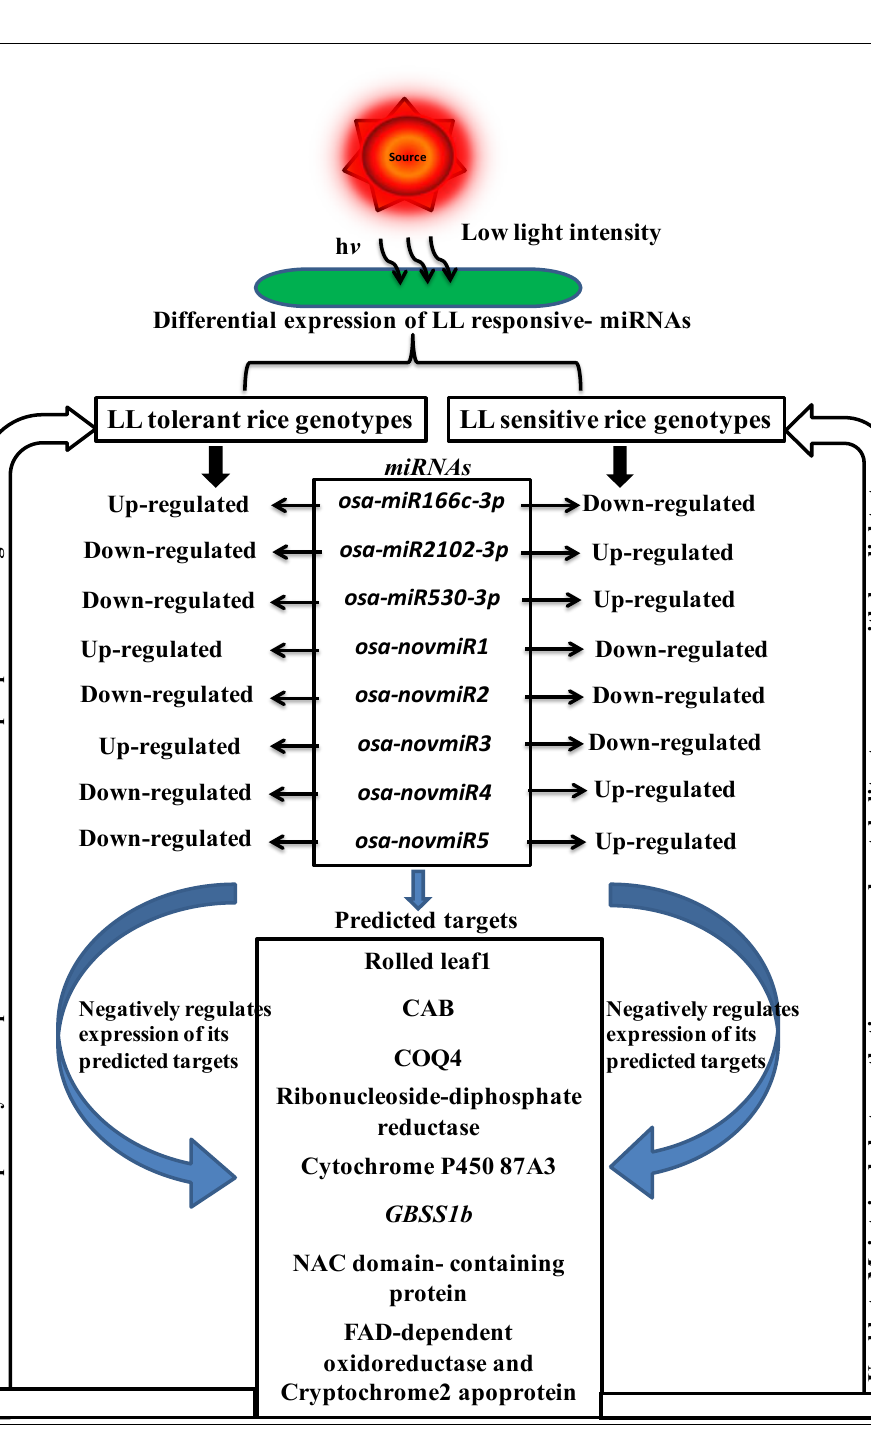
Figure 9. Proposed model depicting miRNA-mediated tolerance or susceptibility due to low light intensity stress in low-light-tolerant and -sensitive rice genotypes. Among identified differentially expressed miRNAs in tolerant and sensitive rice genotypes, three known and five novels were selected. Upregulated miRNAs show downregulation of their respective targets and vice versa. Results indicate that miRNAs are expressed in such a way that their respective targets’ expression involved maintaining photosynthetic and metabolic pathways to cope with low light stress in tolerant rice genotypes, but sensitive rice genotypes were unable to maintain